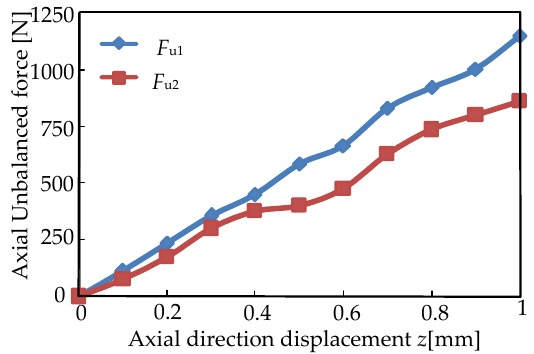
Figure 12. Axial direction displacement versus axial unbalanced force.